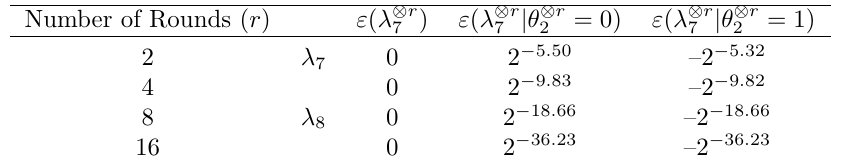
Figure 12: λ 7 Conditioned on θ 2 ( λ 7 | θ 2 ) Table 14: The Conditional Biases of Iterated λ